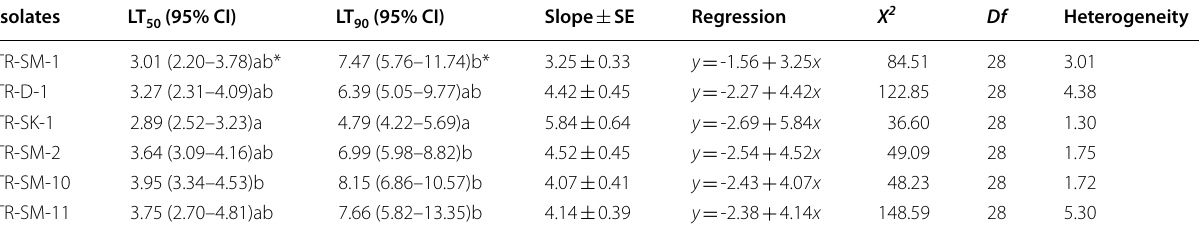
*Within columns, means followed by the same lower-case letters do not differ significantly at p Table 3 Probit analysis data on the mortality time (days) of Thaumetopoea wilkinsoni after the applications of the 1 concentration of Beauveria bassiana and B. pseudobassiana isolates